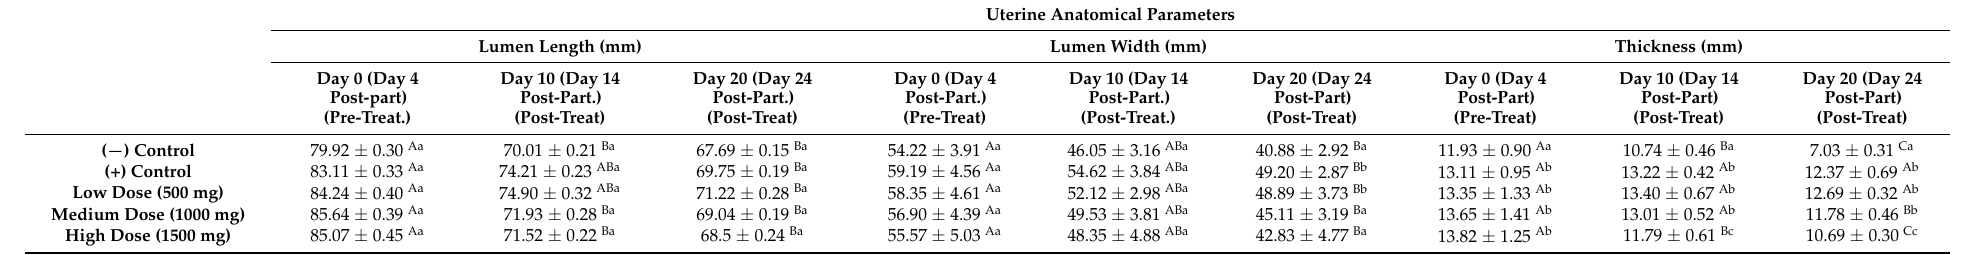
Anatomical measurements of uterine parameters on day 0 (before) and on days 10 and 20 after intrauterine infusion of Micronised Purified Flavonoid Fraction (MPFF; low, medium and high doses) in metritis-diagnosed dairy cows. Letters (A–C) within a row show statistical differences among timepoints ( p < 0.05). Different letters in a column (a–c) show differences among controls/treatment groups ( p < 0.05). Table 3. Effects of intrauterine infusion of Micronised Purified Flavonoid Fraction (MPFF; low, medium and high concentrations) on cervical involution dynamics on days 0, 10 and 20 (days 4, 14 and 24 postpartum, respectively) in metritis-diagnosed dairy cows naturally infected by E. coli during the early postpartum period. Cervical Anatomical Parameters